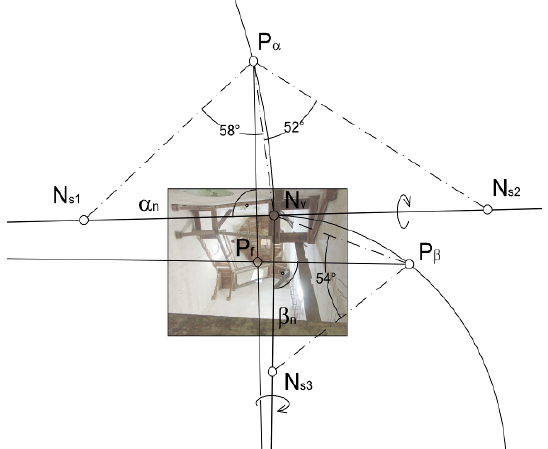
Figure 6. The slope of flights – orientation check.